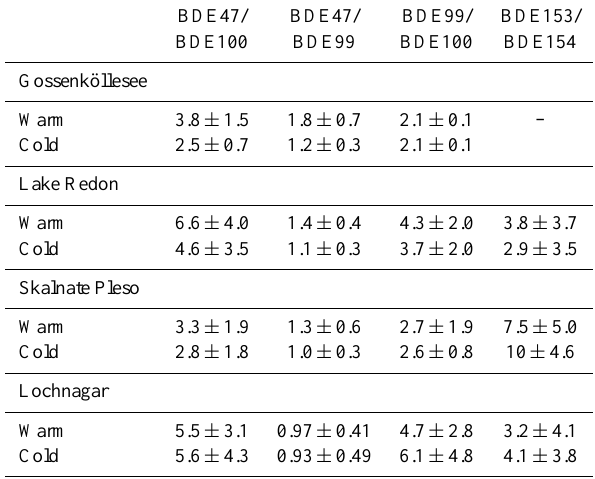
Table 8. Seasonal variations of BDE congener ratios in atmospheric deposition samples.